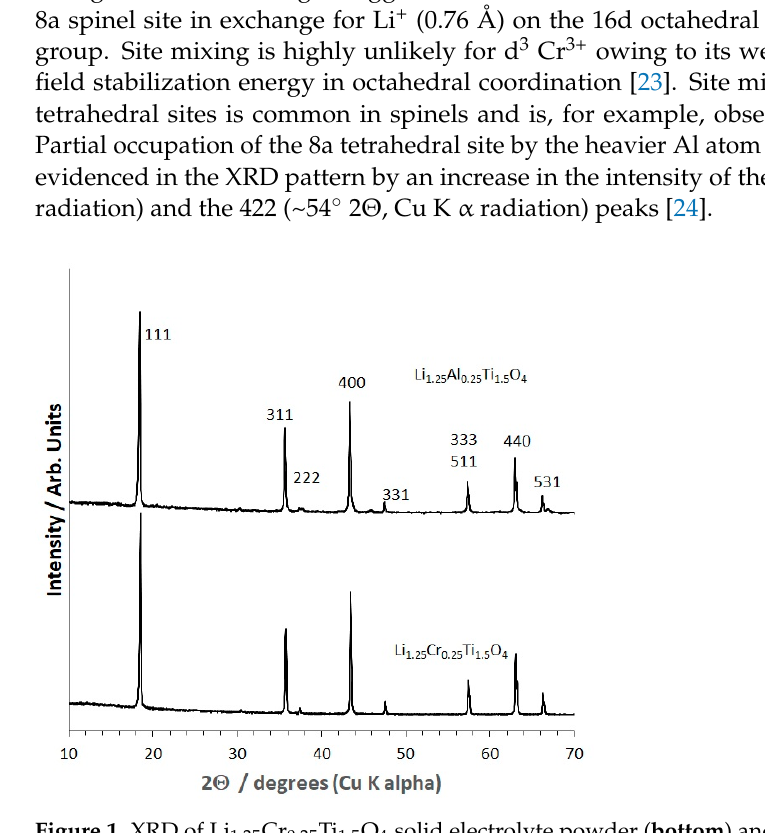
Figure 1. XRD of Li 1.25 Cr 0.25 Ti 1.5 O 4 solid electrolyte powder (bottom) and Li 1.25 Al 0.25 Ti 1.5 O 4 solid elec ‐ trolyte powder (top). XRD peaks are indexed to the Fd 3(cid:3364) m spinel structure. electrolyte powder ( top ). XRD peaks are indexed to the Fd 3 m spinel